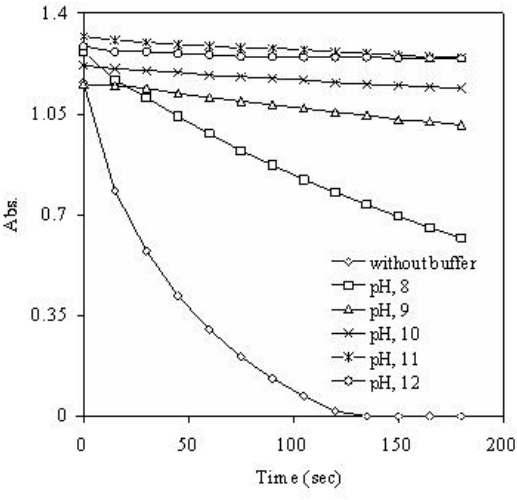
Fig. 5 Effect of pH on kinetic effect of SO 2 −